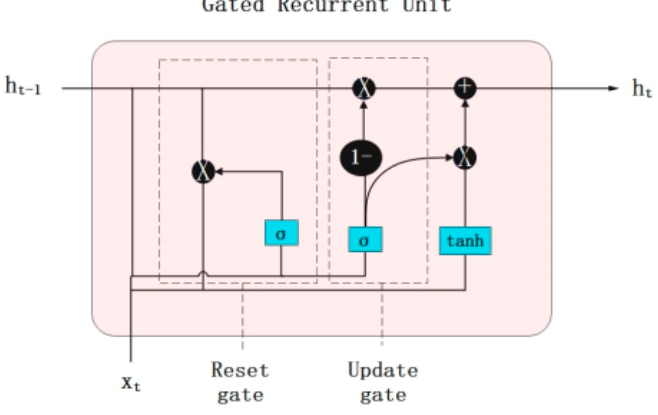
Figure 3. GRU unit